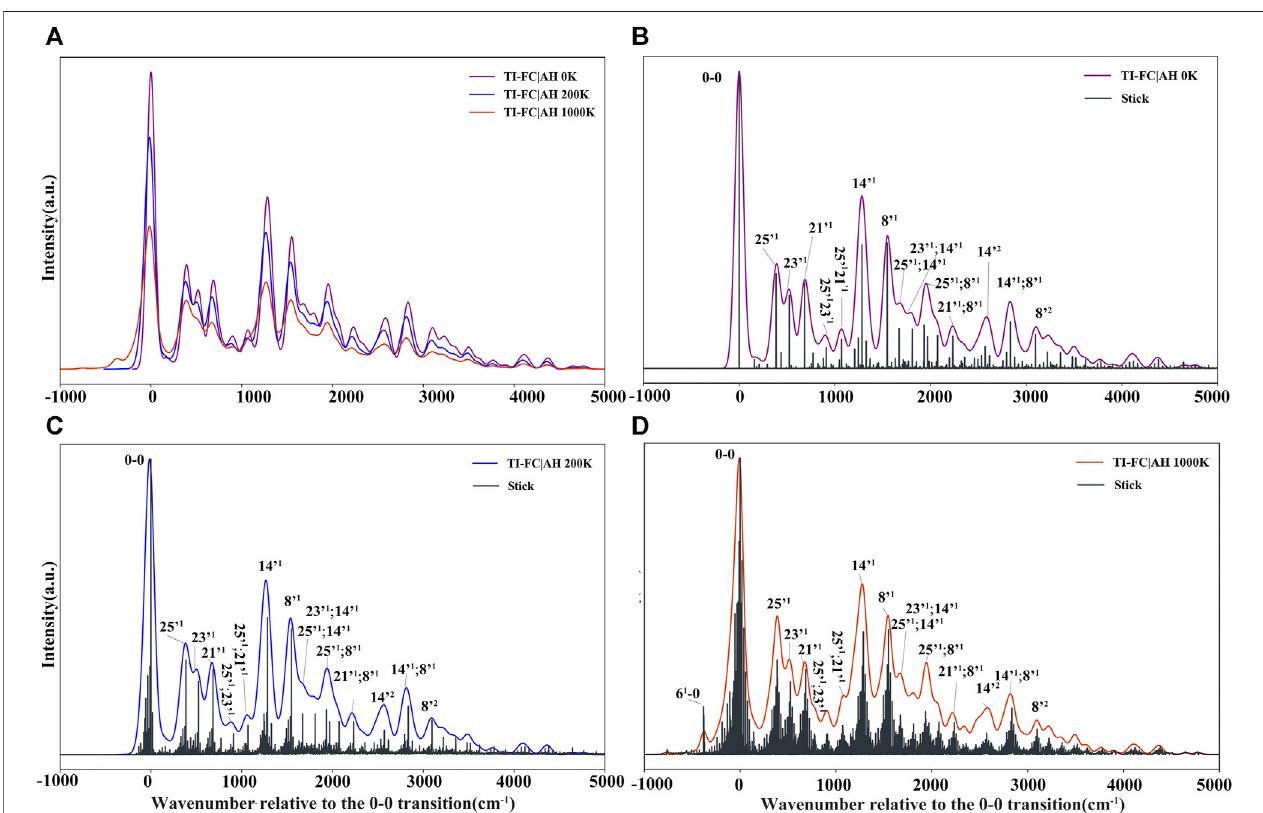
FIGURE 10 | Vibrationally resolved electronic spectra: (A) comparison of spectra simulated at 0 K, 200 K, and 1000 K, spectra intensities have been normalized withrespecttothemostintenseband;[ (B – D) ]convolutedandstickspectrasimulatedat0 K,200 K,and1000 K,respectively.Forallspectra,thelineshapeshavebeen convoluted with Gaussian distribution functions with HWHM of 50 cm − 1 . The assignment for a selected vibronic transition (stick spectrum) is reported, where “ m n ” and “ m ’ n ” represent the vibrational state with n quanta associated with modes m (initial/ground state) and m ’ ( fi nal/ionic state), respectively.